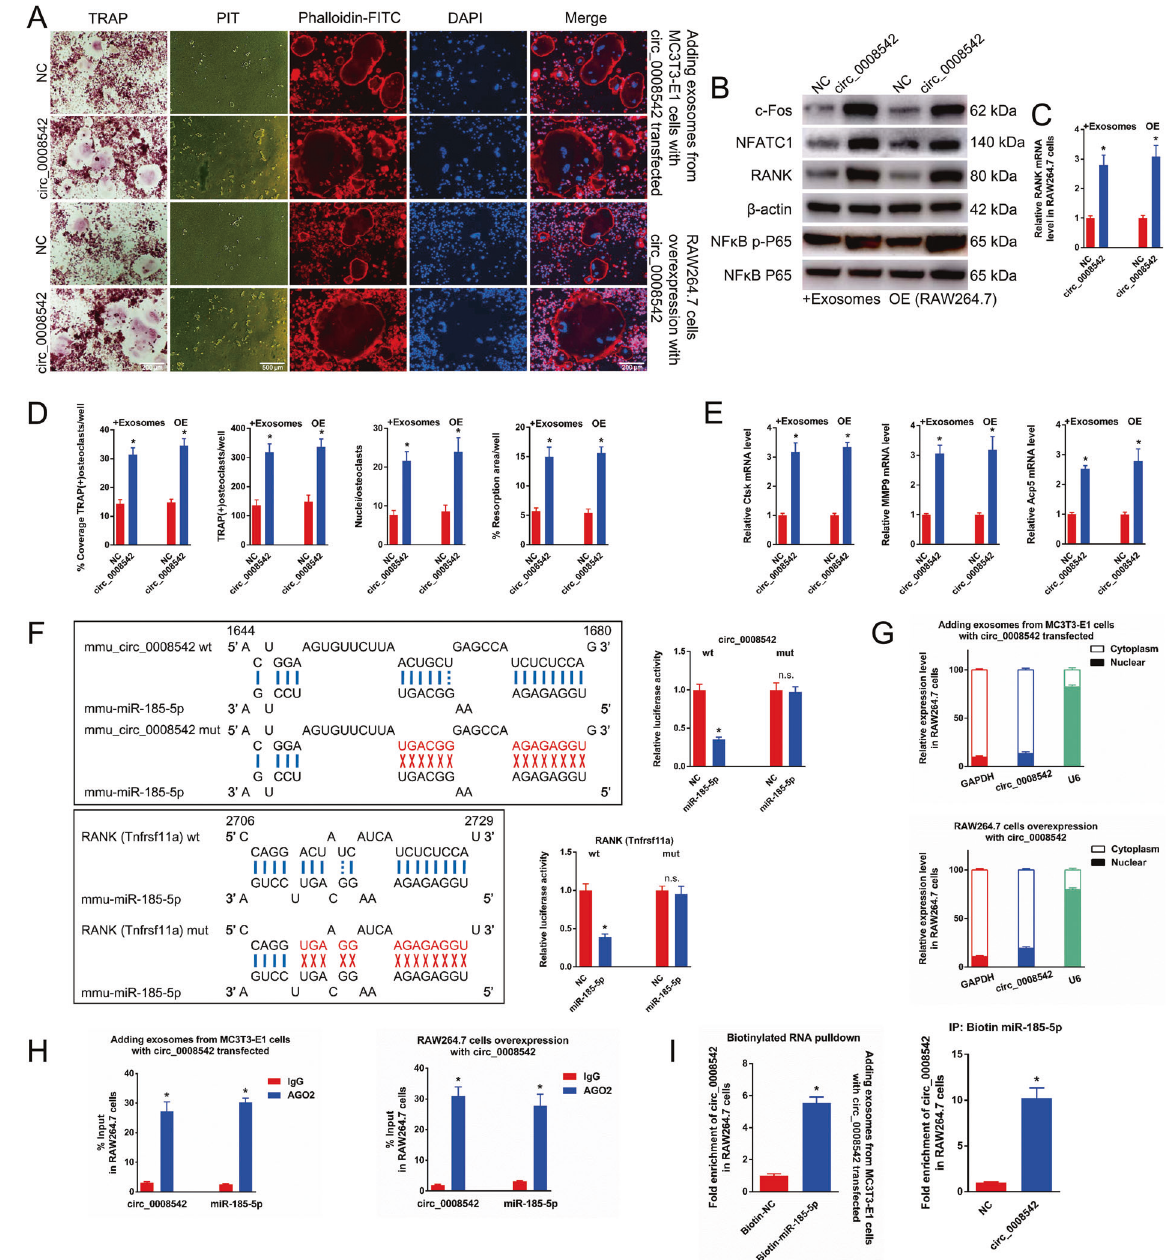
Fig. 3 The effects of circ_0008542 on osteoclasts. After transfection of circ_0008542 in RAW264.7 cells or addition of exosomes containing circ_0008542 overexpression in RAW264.7 cells, A TRAP staining, pit formation assay, and F-actin band staining were applied to detect osteoclast differentiation and bone resorption ability between the two groups with or without circ_0008542. B Protein levels of c-fos, NFATc1, RANK, and NF κ B p-P65 in RAW 264.7 cell lysates between two groups with or without circ_0008542 were analyzed by western blot. C Relative expression level of RANK in RAW 264.7 cells between two groups with or without circ_0008542. D Histograms of coverage rate, number and nuclei of TRAP-positive osteoclasts, and bone resorption area rate between the two groups. E Relative expression levels of Ctsk, MMP9, and TRAP in RAW 264.7 cells between the two groups. F After construction of the circ_0008542 fragment luciferase reporter or RANK gene fragment luciferase reporter with wild-type or mutant complementary binding sites, relative luciferase activity was detected between the miRNA-185-5p group and the NC group. G Cytoplasmic and nuclear fractionation assay was applied to detect localization of circ_0008542. H RIP assay was performed to detect the enrichment rate of circ_0008542 and miRNA-185-5p. I RNA pulldown assay with 3 ′ -end biotinylated miRNA-185-5p. The binding activities of circ_0008542 to 3 ′ -end biotinylated miRNA-185-5p with circ_0008542 overexpression. Data were representative of three independent experiments expressed as the mean ± SD (* p < loading group recorded signi fi cant vertical bone loss at distal and However, clinical studies have shown that this loaded method labial sites than the conventional loading group [33]. The degree simultaneously causes marginal bone resorption and increases the of primary stability during immediate loading protocols is failure rate of osseointegration. For example, the previous study dependent on several factors including bone density and quality, proved that after 3 years of follow-up period, the immediate